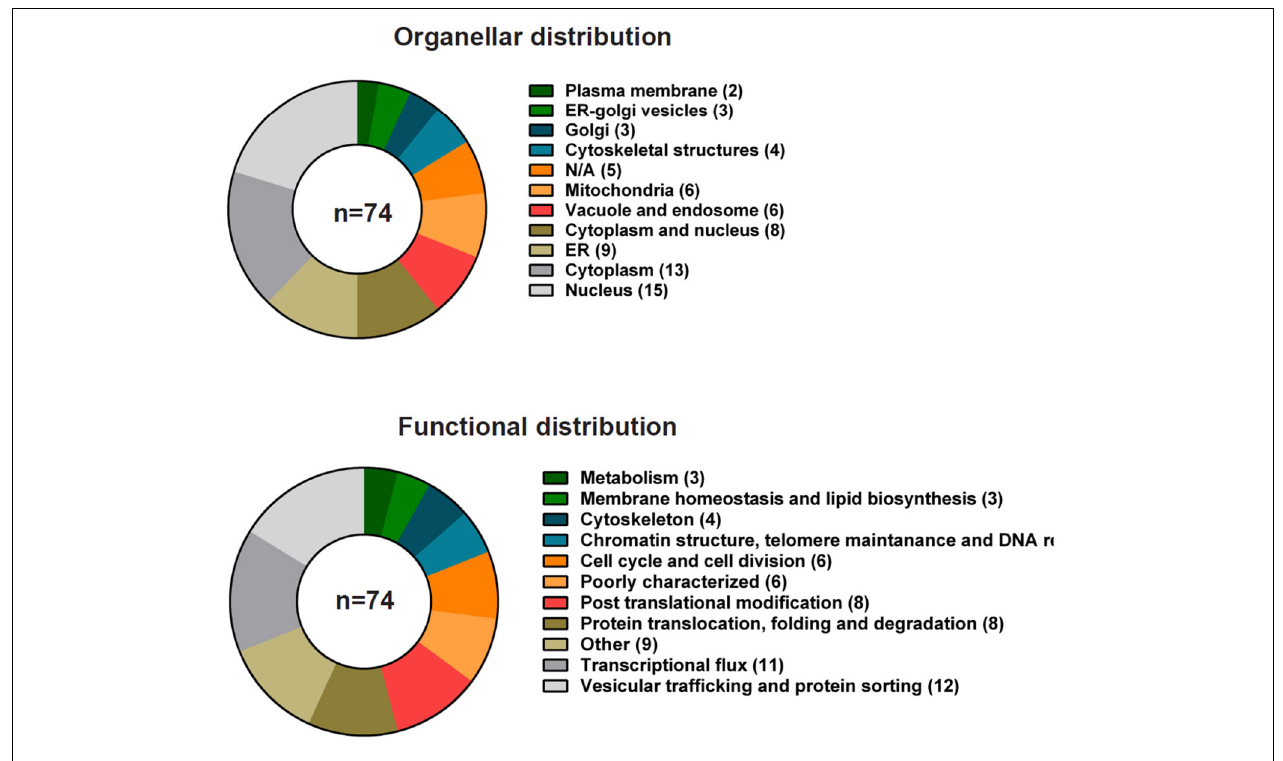
FIGURE 5 | Genetic interactions of YPK9 in S. cerevisiae grouped according to cellular localization and function. Summary of the known genetic interactions of the yeast ATP13A2 ortholog YPK9 . The data were